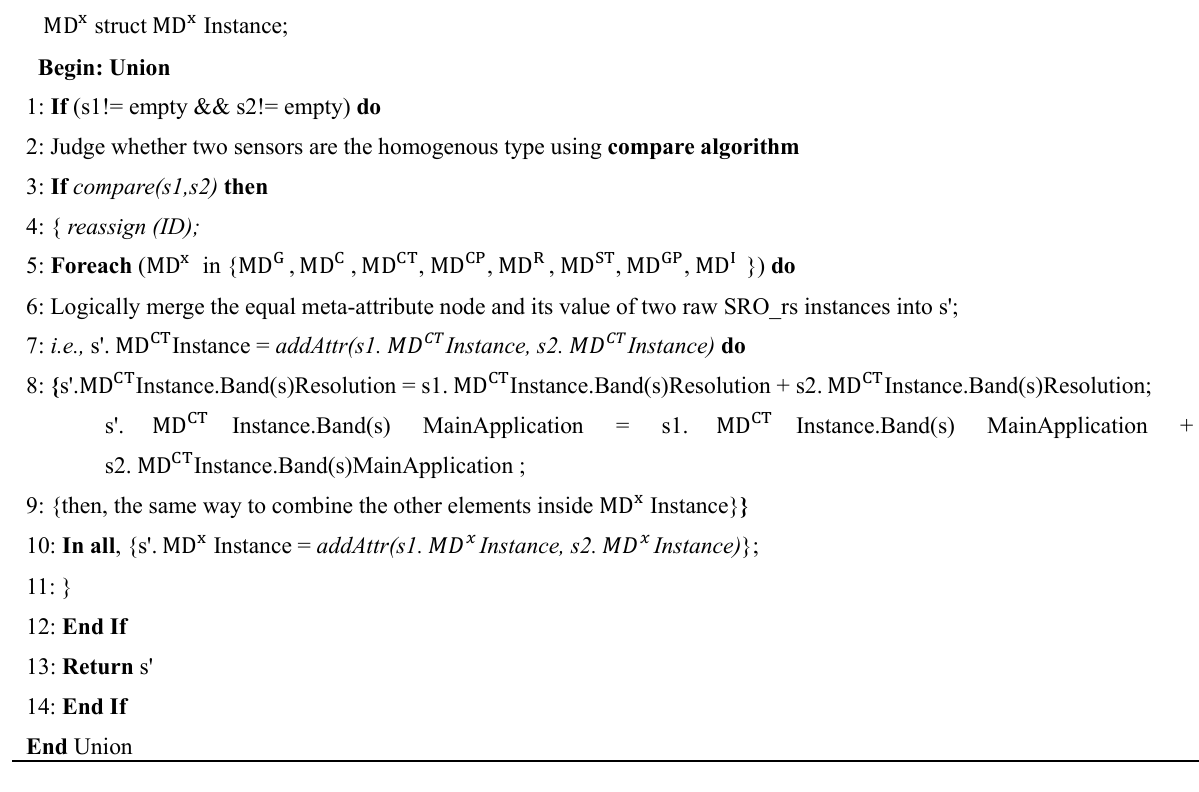
Algorithm2: Compare algorithm of two remote sensor resource objects SRO_rs